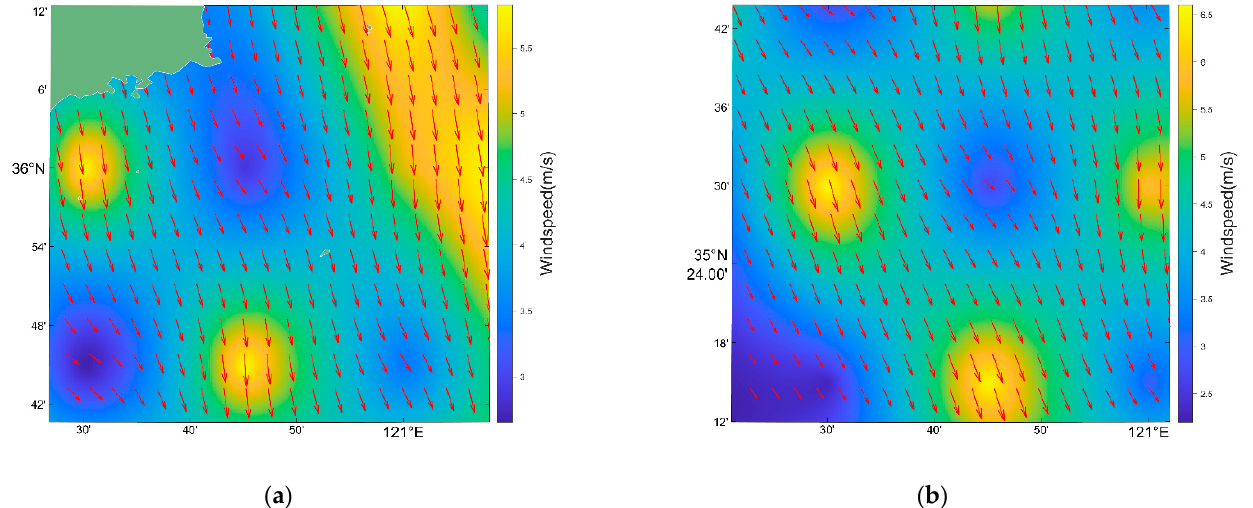
Figure 4. ( a ) The ECMWF reanalysis wind field of region ( b ) in the Figure 1. The ECMWF reanalysis wind field of region c in the Figure 1.